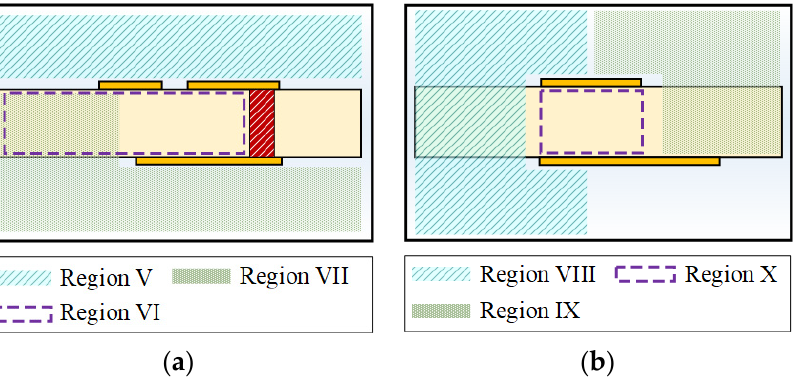
Figure 15. Analysis regions of the cross-section of the CPS-to-PSL transition: ( a ) for the CPS-to- asymmetric PSL transition, ( b ) for the asymmetric PSL-to-PSL transition.